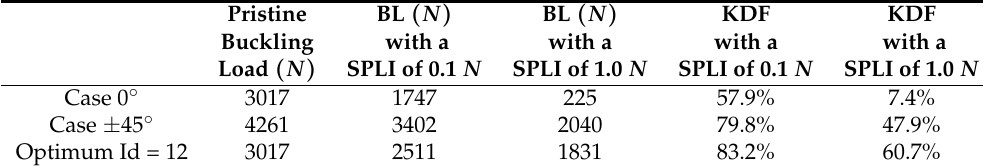
Table 11. Imperfection sensitivity of Case 0 ◦ , Case ± 45 ◦ , and the design optimum ID = 12 from Table 10. Pristine BL ( N ) BL ( N ) KDF KDF Buckling with a with a with a with a Load ( N ) SPLI of 0.1 N SPLI of 1.0 N SPLI of 0.1 N SPLI of 1.0 N Case 0